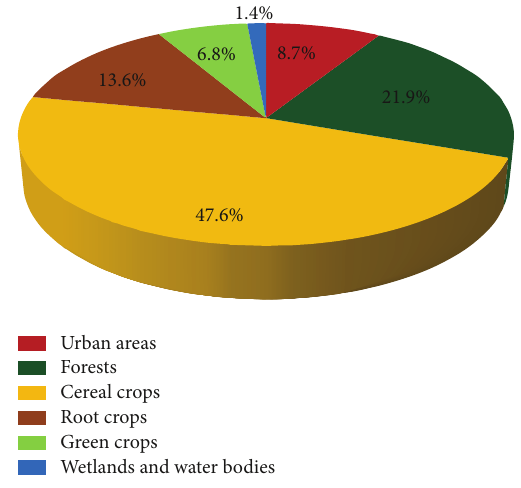
Figure 4: Land-use units in the Poznan province based on the Statistical Yearbooks for